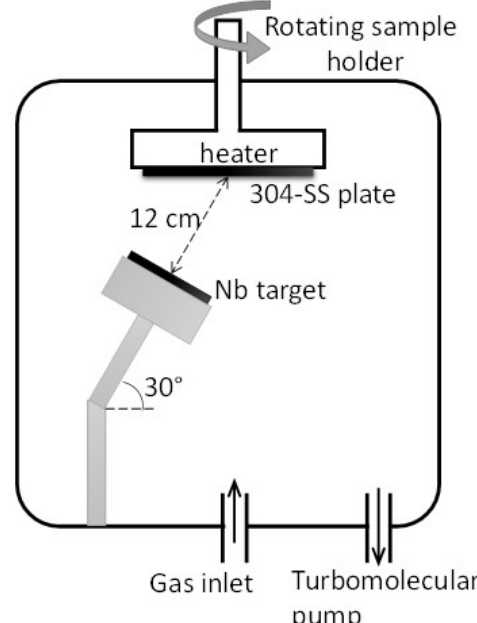
Figure 1. Schematic representation of the reactive Radio Frequency (RF) magnetron sputtering used for Nb and NbN coating deposition. Table 1. Radio frequency (RF) sputtering parameters used for the deposition of Nb, NbN, and Nb/NbN coatings. Table 2. Sample labels and PVD coating conditions of each